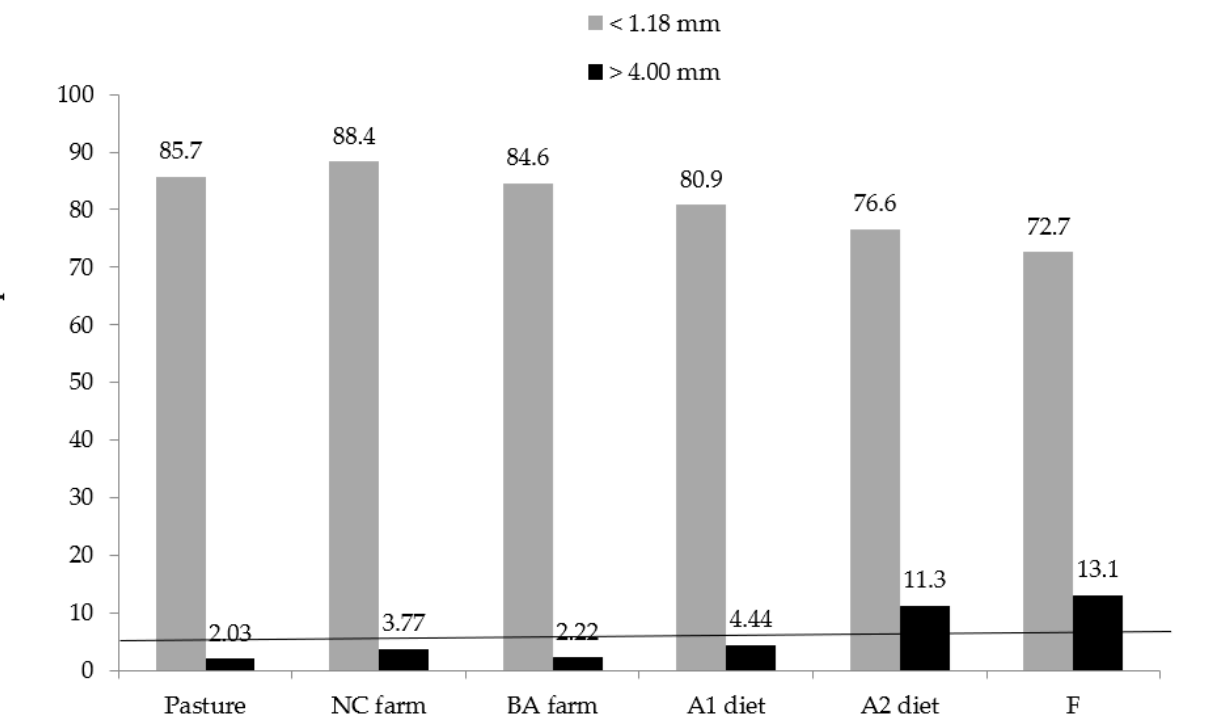
Figure 2. Relationship between the overall mean of percentage of fecal particles larger than 4 mm and smaller than 1.18 mm from cattle raised in feedlots and on pasture. The horizontal line determines the empirical value (4% of fecal dry matter as particles >4 mm), above which the animals had subacute ruminal acidosis, diagnosed based on clinical examinations performed in the field, associated with ruminal and fecal pH, fecal score and blood lactate